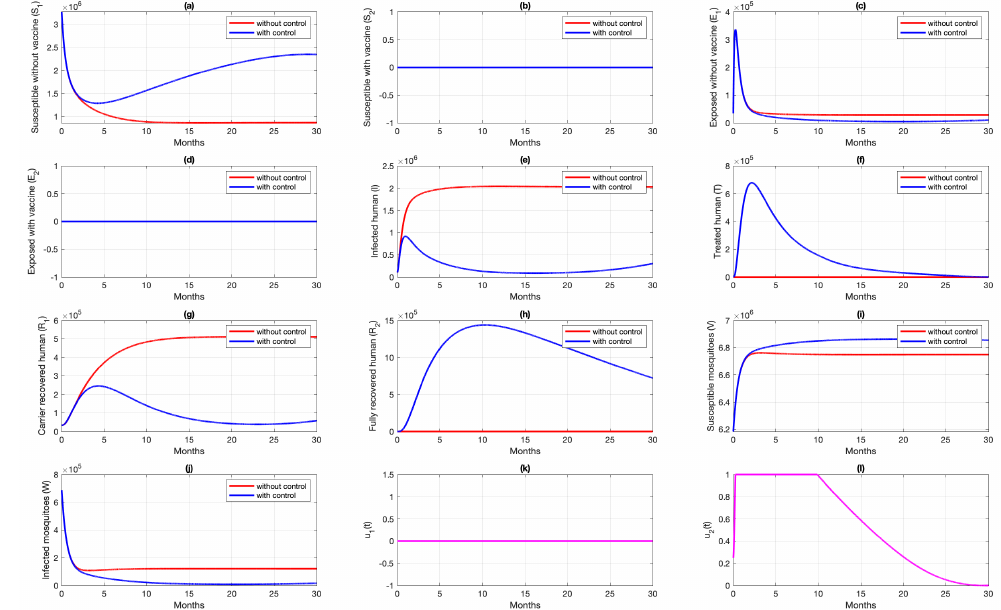
Figure 9. Dynamics of human ( a – h ), mosquitoes ( i , j ), and controls ( k , l ) under the scenario of transmission-blocking treatment intervention only applies. Blue and red curve represents implemen- tation strategies with and without